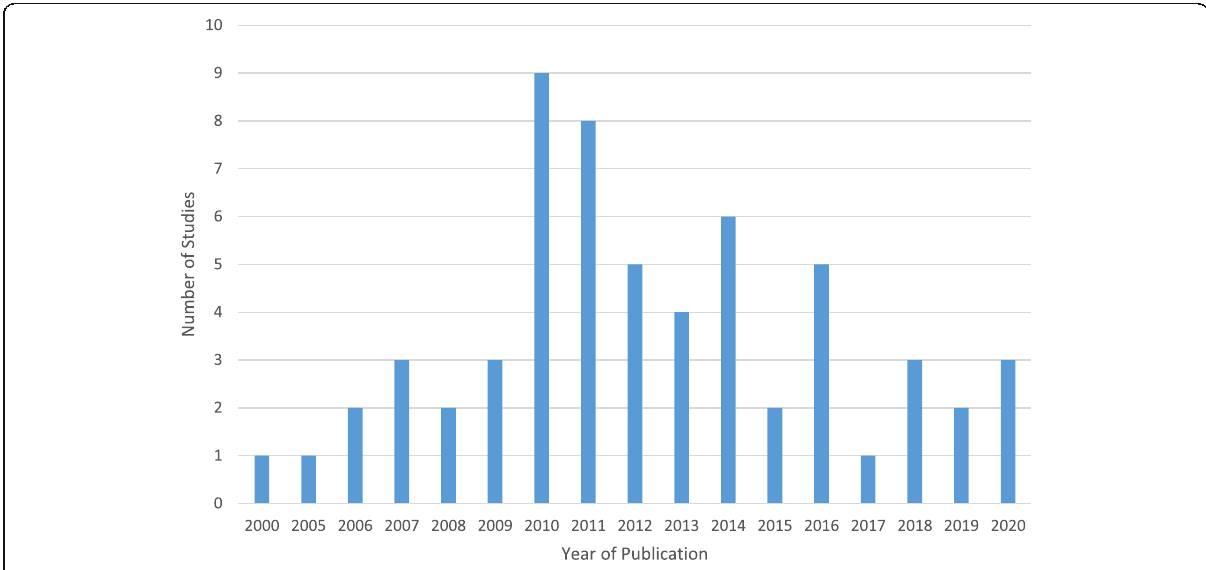
Fig. 2 Distribution of included studies by year of publication